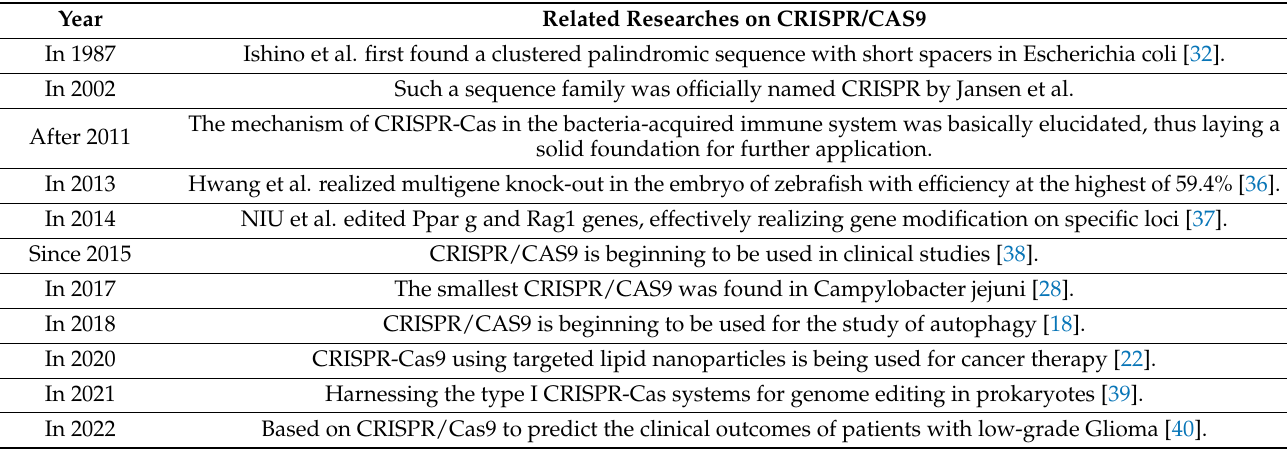
Table 1. Discovery history of CRISPR/CAS9